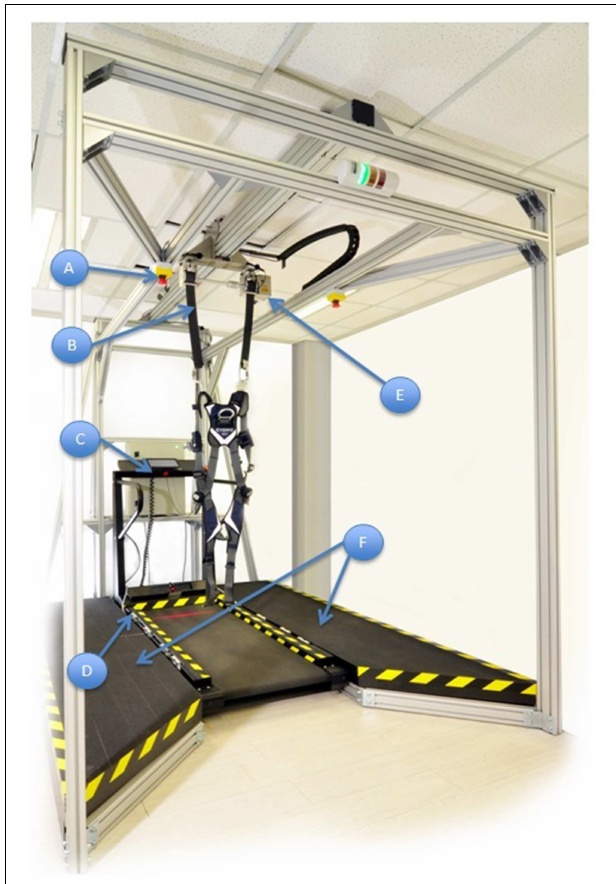
FIGURE 1 | The variable automated speed sensing treadmill is a semi-automated integrated rehabilitation system with multiple sensors and microcontrollers. (a) Additional emergency stop buttons. (b) A fall prevention harness with sensors for detection of fall motion, with automatic relay to the main controller to stop the treadmill. (c) Pre-programmed exercise parameters within Micro controller system, which can be adjusted to optimize training of the subject. (d) Laser beam foot sensors to detect subject’s walking gait on the belt and modify the exercise speed according to a preset algorithm. (e) Wireless control to reposition the harness to be overhead of the subject’s position on the belt. (f) Flanking platforms for the physiotherapist to stand beside either side of the